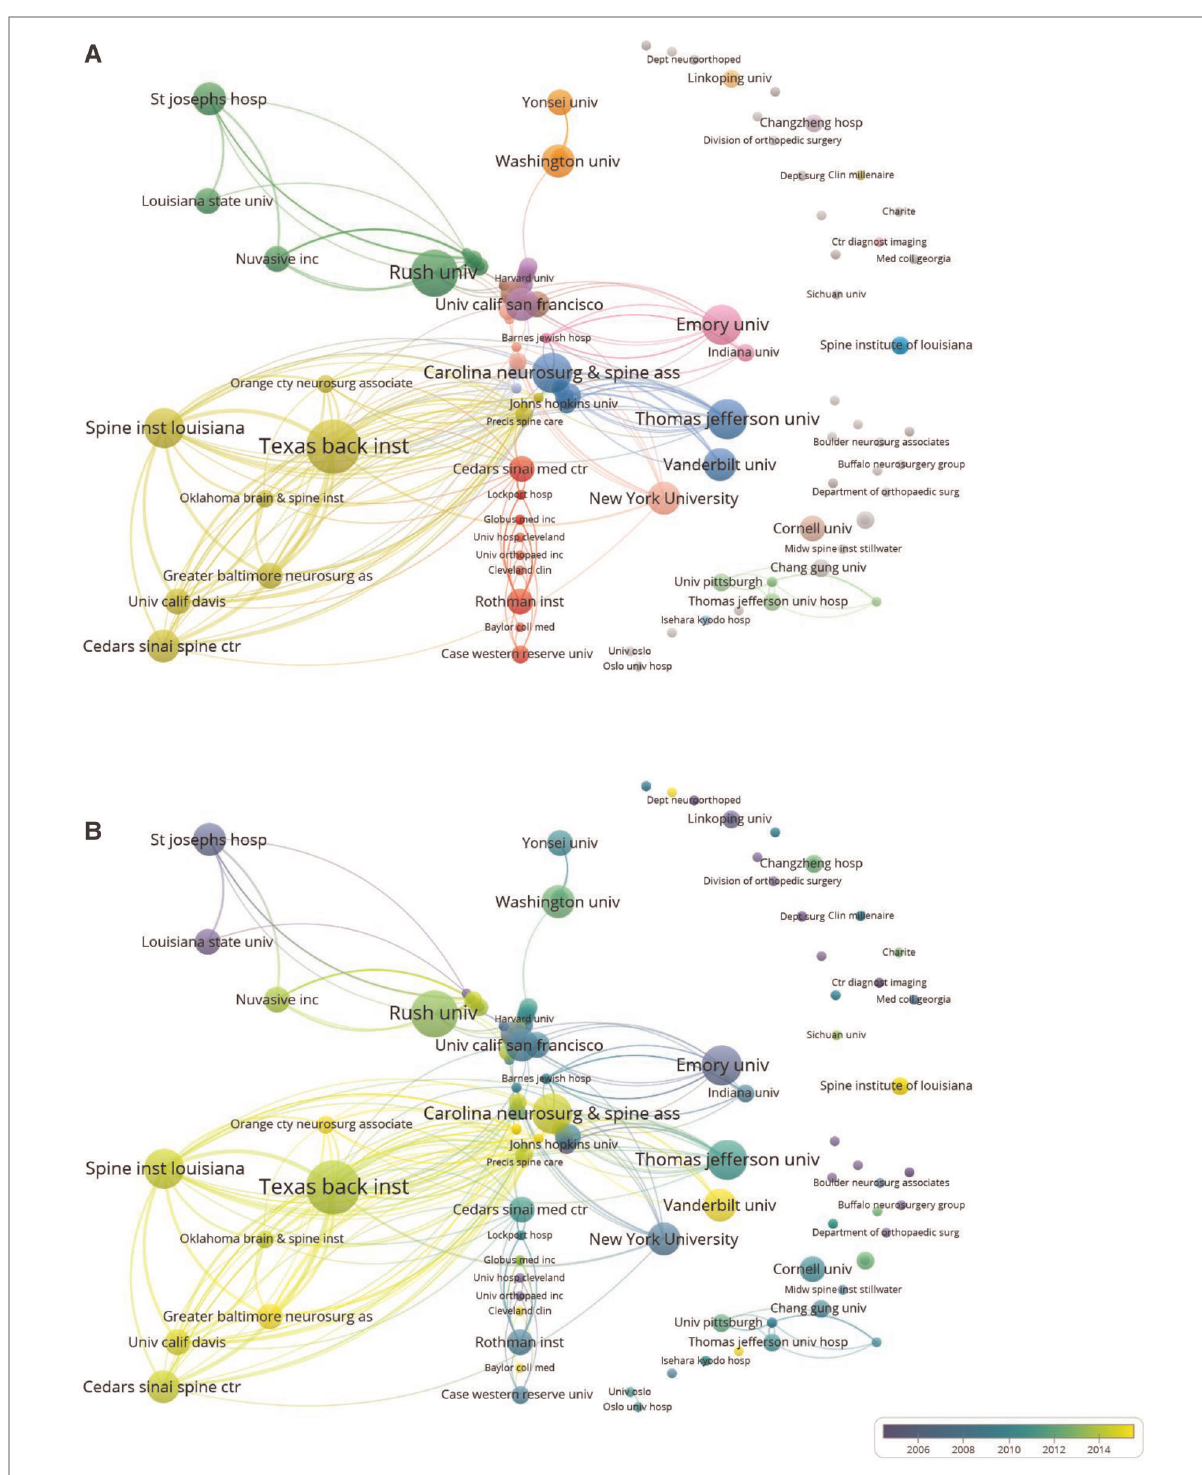
FIGURE 3 Degree of centrality analysis of the institutions of the whole 100 top-cited articles. ( A ) Overlay visualization. ( B ) Time-dependent overlay visualization.